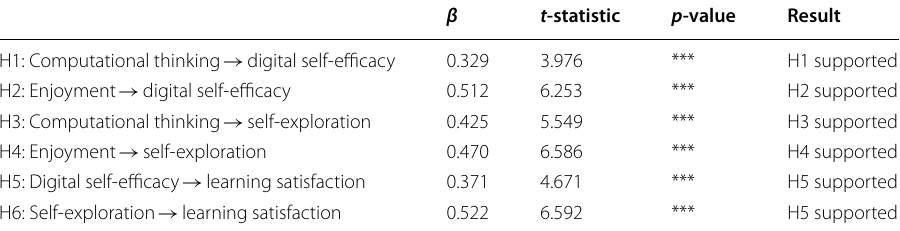
Table 3 Summary of the hypothesis results